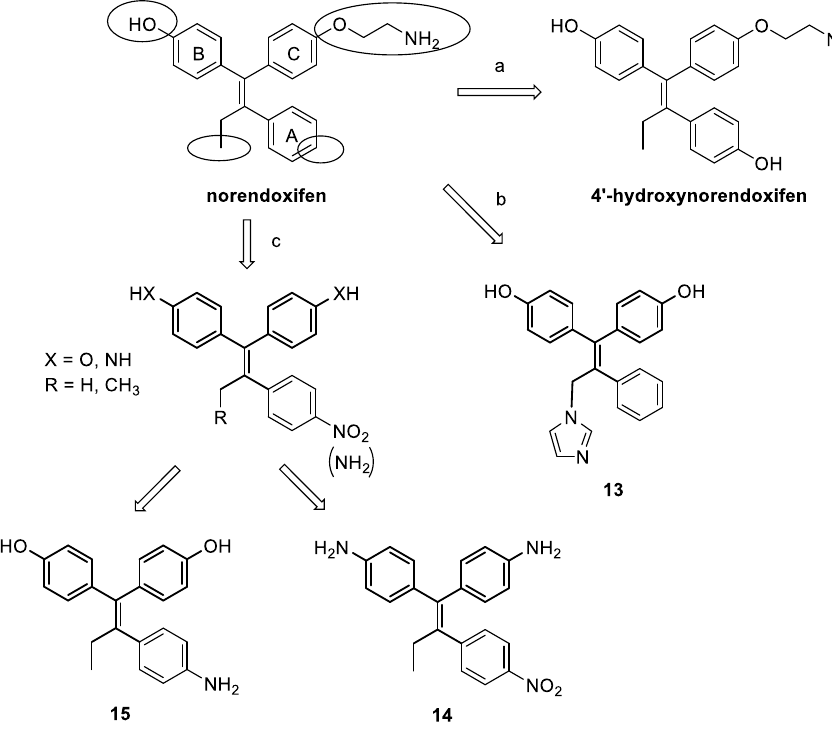
Figure 11. Structure-activity studies on norendoxifen. Main modifications led to the introduction of a hydroxyl group on ring A (a), removal of amino side chain and introduction of heme-coordinating moieties (b) and substitutions with amino or nitro groups (c).